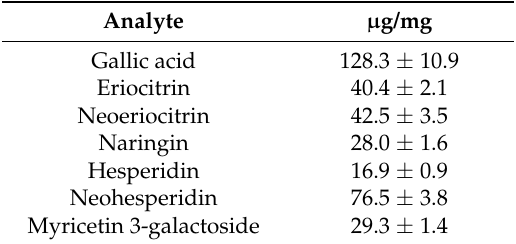
Table 2. Main components of the pompia extract.